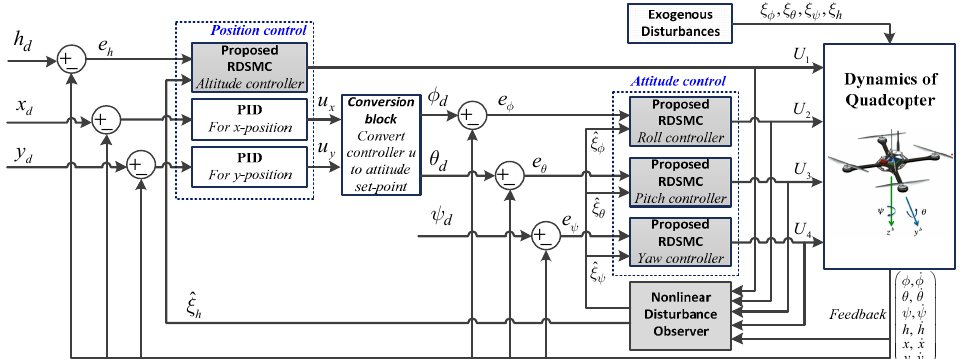
Figure 3. Block diagram of full controller of a quadcopter, the proposed algorithm is applied in the attitude and altitude control only. The traditional PID is used in horizontal position control.